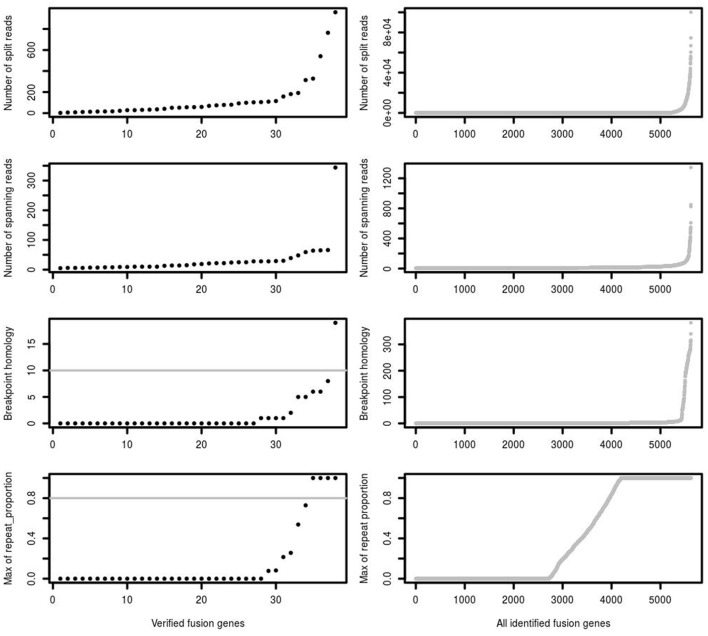
The number of split reads, spanning reads and breakpoint homology between verified and identified fusions. deFuse reported most of the verified fusion genes in 16 glioblastoma samples as containing <200 split reads, <50 spanning reads and <10 bp breakpoint homology. The maximum proportion of spanning reads in fusion partners aligned on a repeat region (repeat_proportion) is <80% among most of the verified fusions.